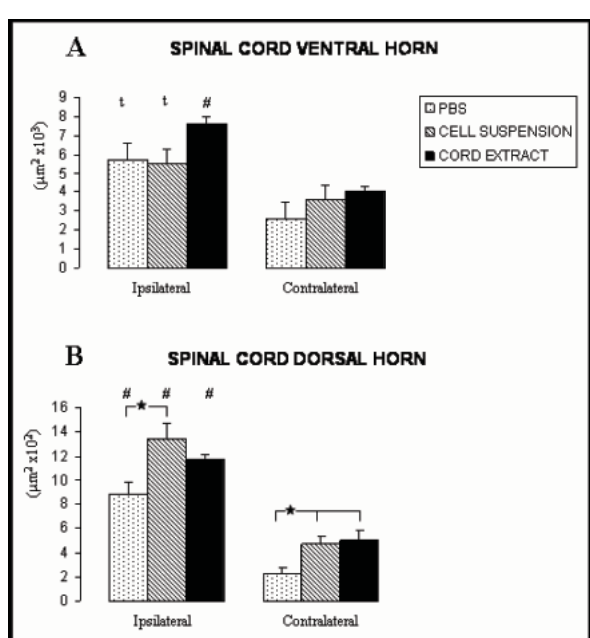
FIGURE 4 - Effects local inoculation of phosphate buffered saline (PBS), a cultured Schwann cell suspension or a injured spinal cord extract in a reservoir performed by unilateral double contiguous crush in the rat sciatic nerve on the area of the GFAP immunoreactivity, marker for astrocytes, in the ventral (A) and dorsal (B) horns of the gray matter of the rat spinal cord, ipsilaterally and contralaterally to axotomy. Immunoreaction product was quanti fi ed by means of microdensitometric/ morphometric image analysis. One way ANOVA analysis of variance was used for multiple comparisons among groups (* p< 0.05). The unpaired t test was employed to compare the ipsilateral with contralateral sides (t p=0.08 and #